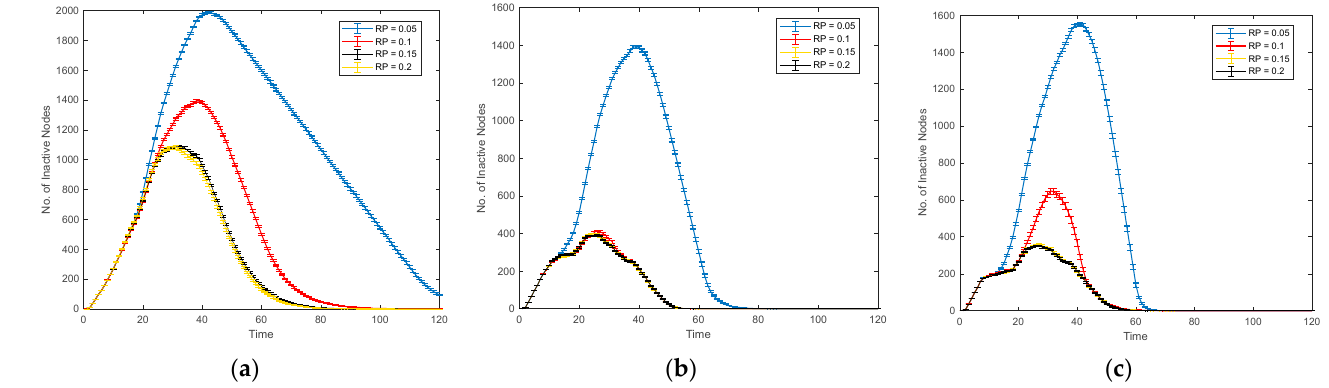
Figure 8. The number of inactive nodes as a function of time under load-based failures with different recovery potentials for ( a ) α = 0.2, ( b ) α = 0.5, ( c ) α = 0.8.